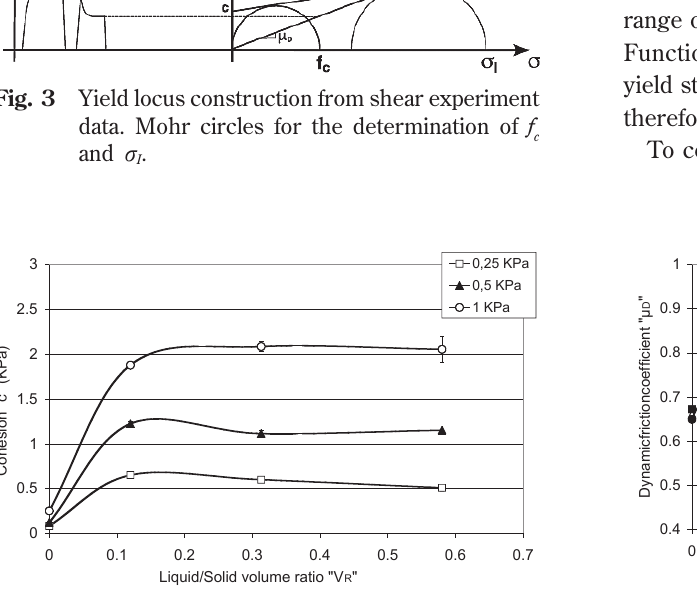
Fig. 4 Cohesion (left) and dynamic friction coefficient (right) of the calcite 50-125 µm as a function of liquid amount, for 3 consolidation normal stresses (0.25, 0.5 and 1